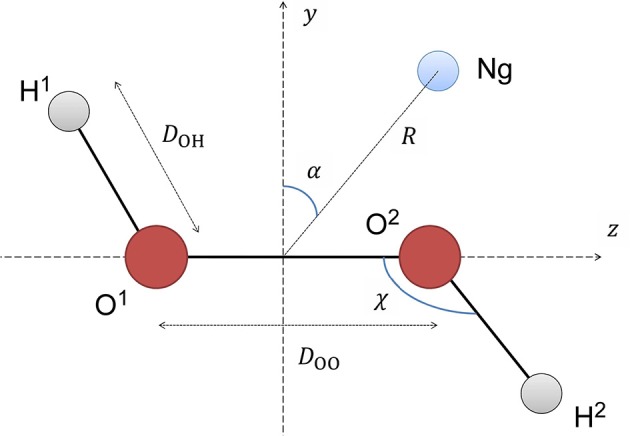
Definitions of the coordinate system used to represent the H2O2-Ng PES (see text for more details).